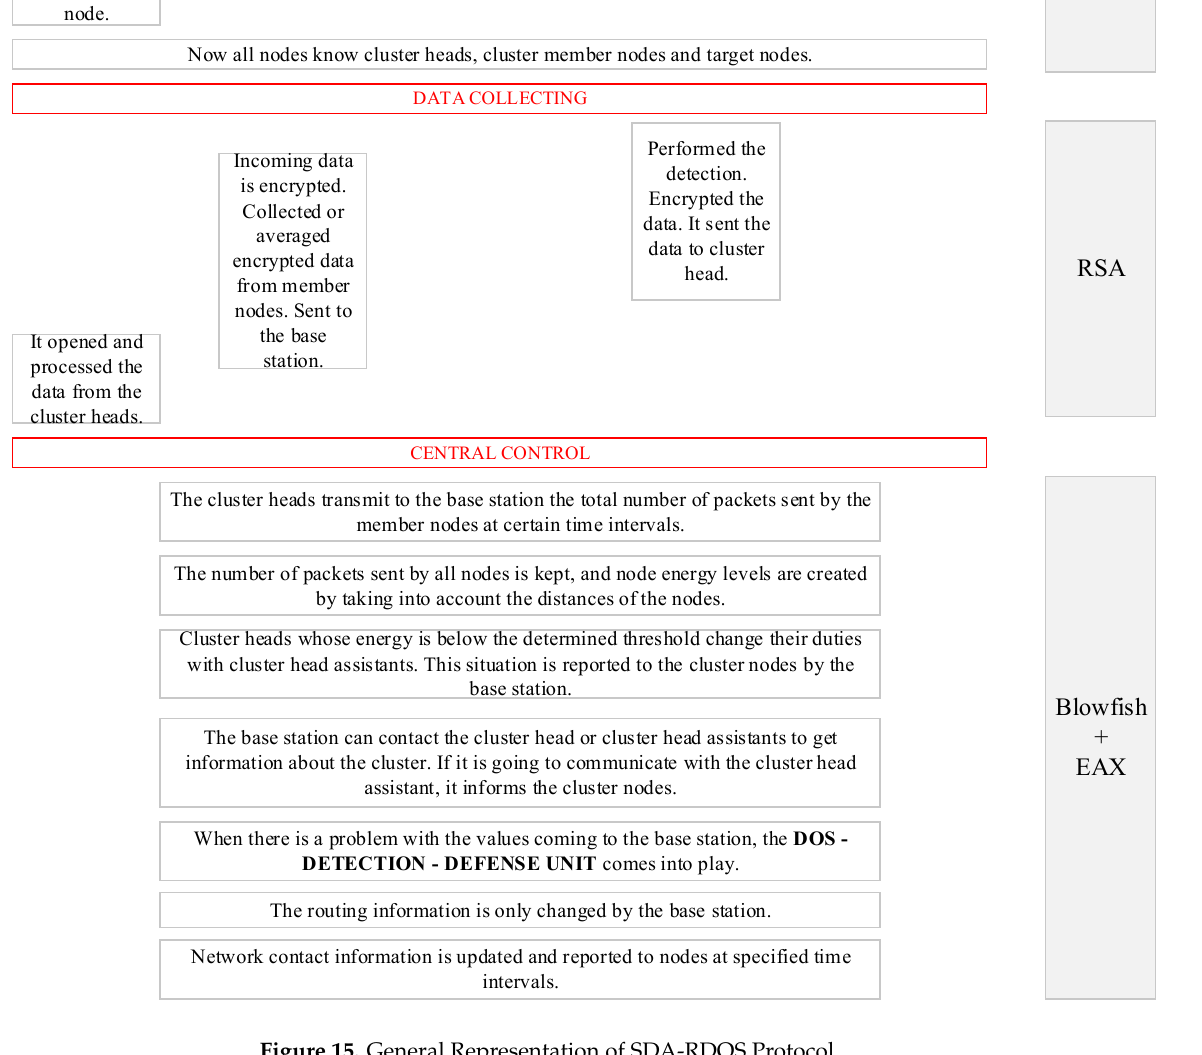
Figure 15. General Representation of SDA ‐ RDOS Protocol.